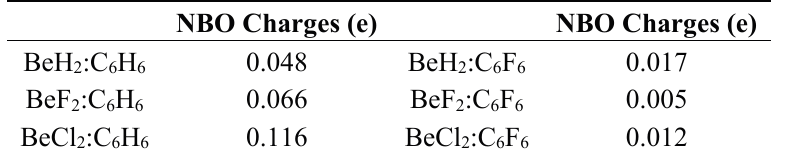
Table 2. NBO charges (e) of the aromatic system within the BeR 2 :C 6 X 6